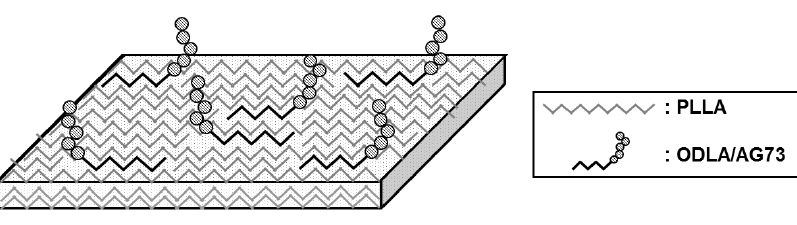
Figure 1. Illustration of the surface structure of PLLA/ODLA-AG73